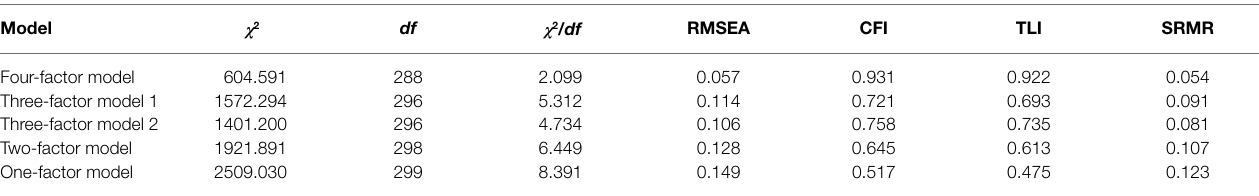
TABLE 1 | Results of confirmatory factor